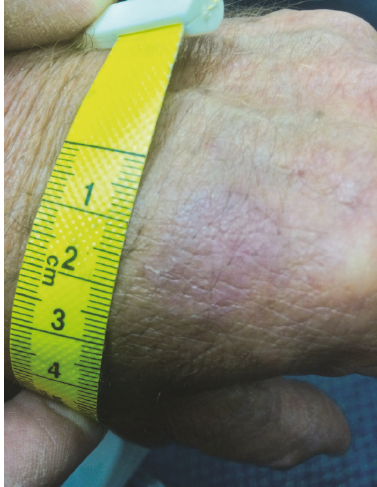
Figure 2: Site of actinic keratosis at three months (immediately after honey treatment).